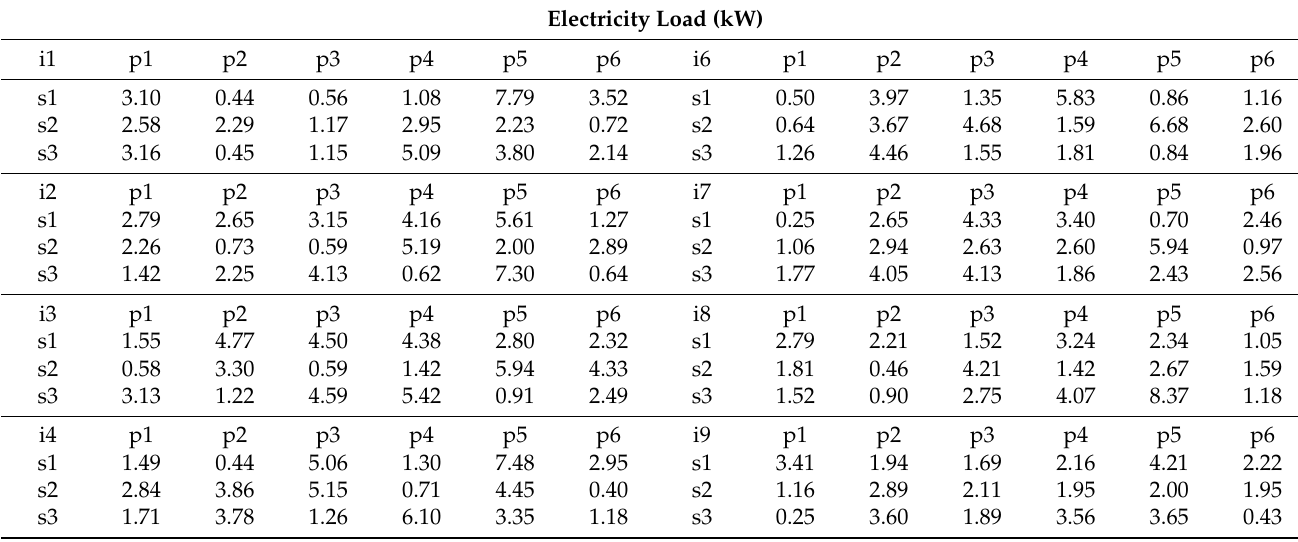
Table 3. Electricity loads for the 10 dwellings